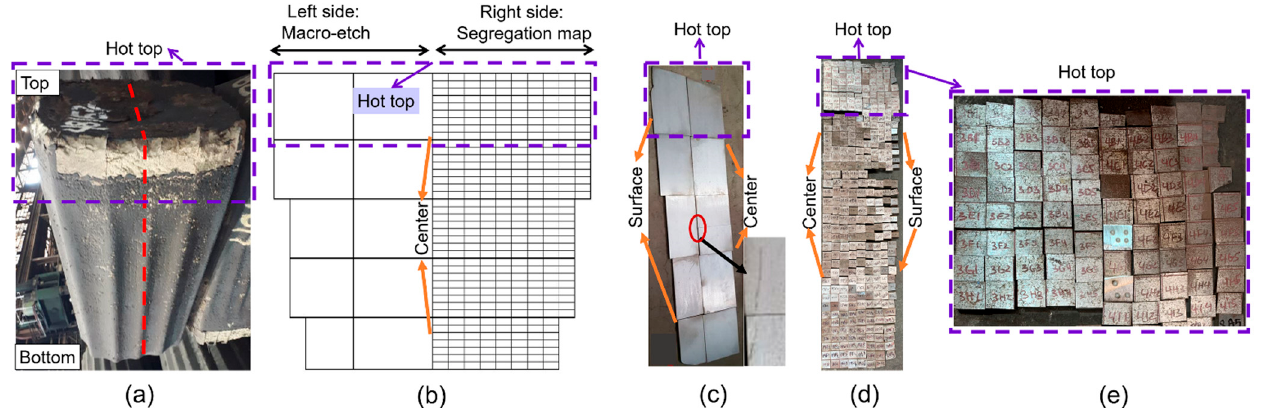
Figure 2. ( a ) 12 MT ingot after casting, red dash line presents the position of the cutting section, ( b ) Central longitudinal section, the right side was used for the macrosegregation map and the left side was used for macro-etch, ( c ) Cutting blocks of the ingot for macro etching, ( d ) Cutting samples of the ingot for chemical mapping and ( e ) Enlarge image showing the hot top cut into smaller samples for analysis.